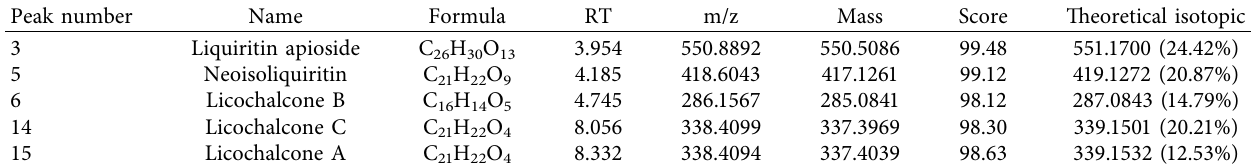
Table 9: Assignment of common peaks in fingerprint of flavonoids in Glycyrrhiza uralensis Fisch. based on HPLC-Q-TOF/MS. Peak